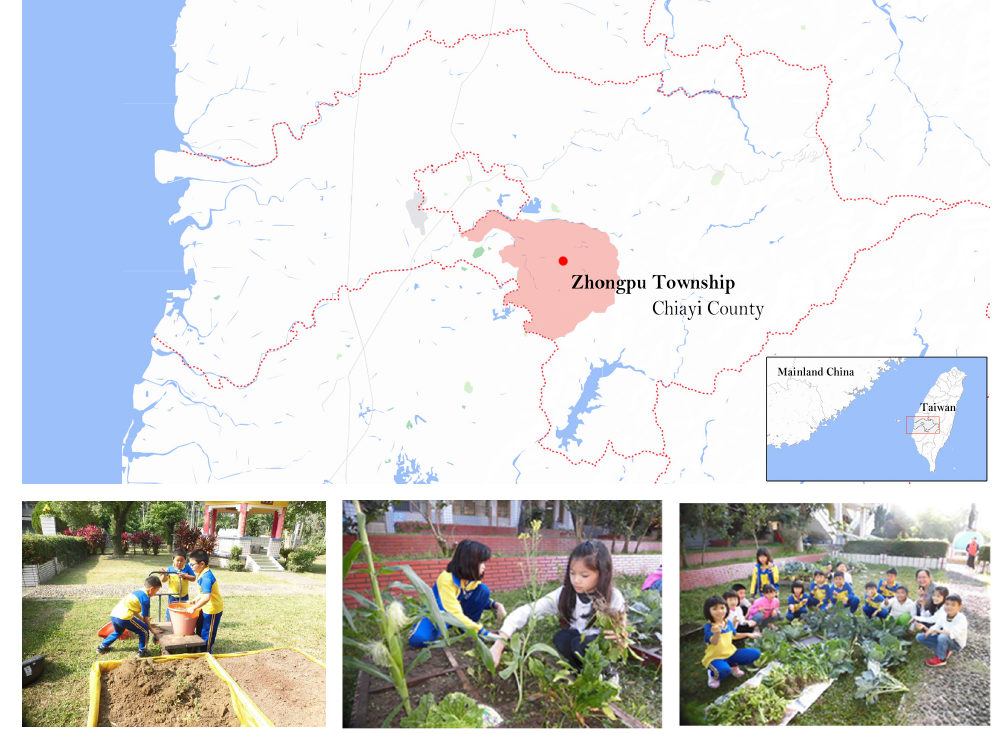
Figure 2. Location of the study area ( upper ) and students participating in the study ( lower ).